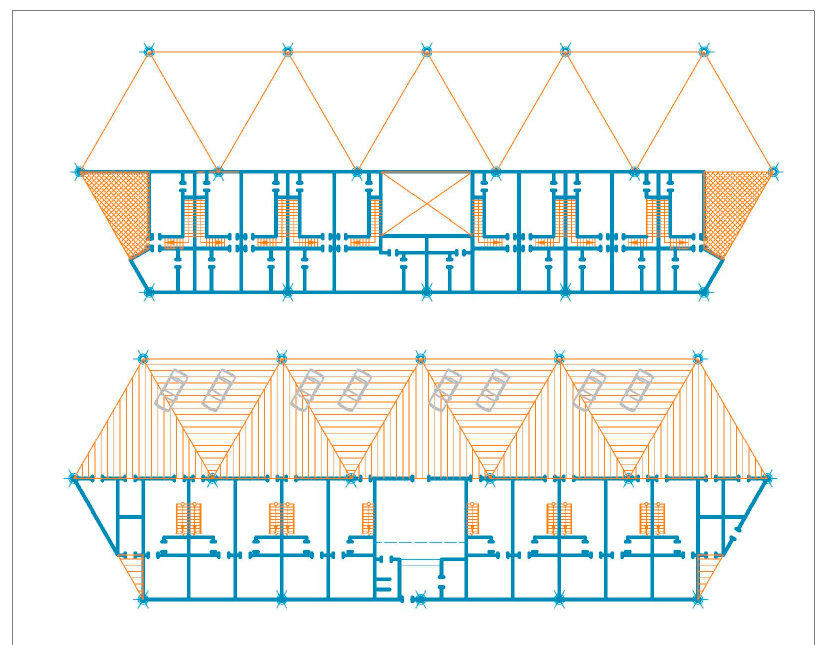
Figure 11. Planning solutions: the Highly comfortable motel (10 apartments) with parking under a canopy—1st, 2nd floors.